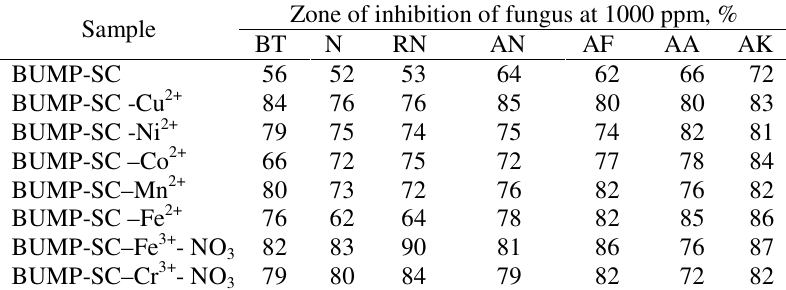
Table 3. Antifungal activity of bUMP-SC ligand and its metal chelates.